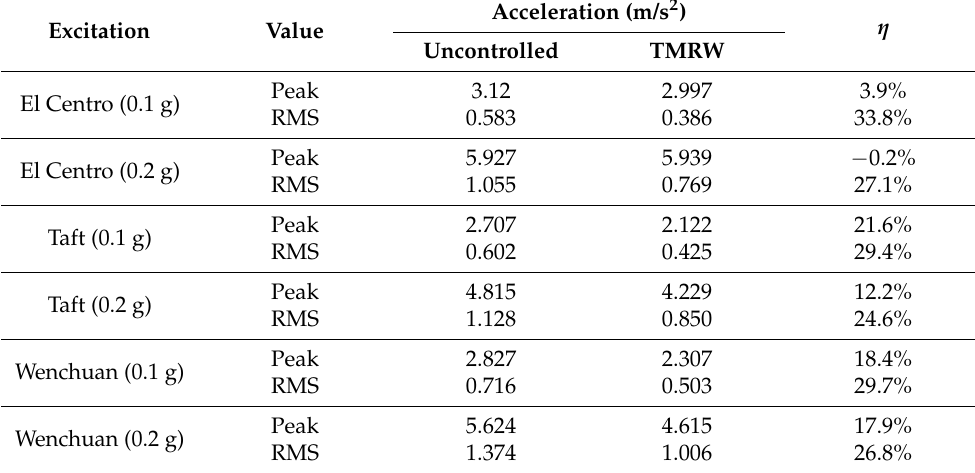
Table 2. Control effectiveness of the acceleration responses (the top floor).